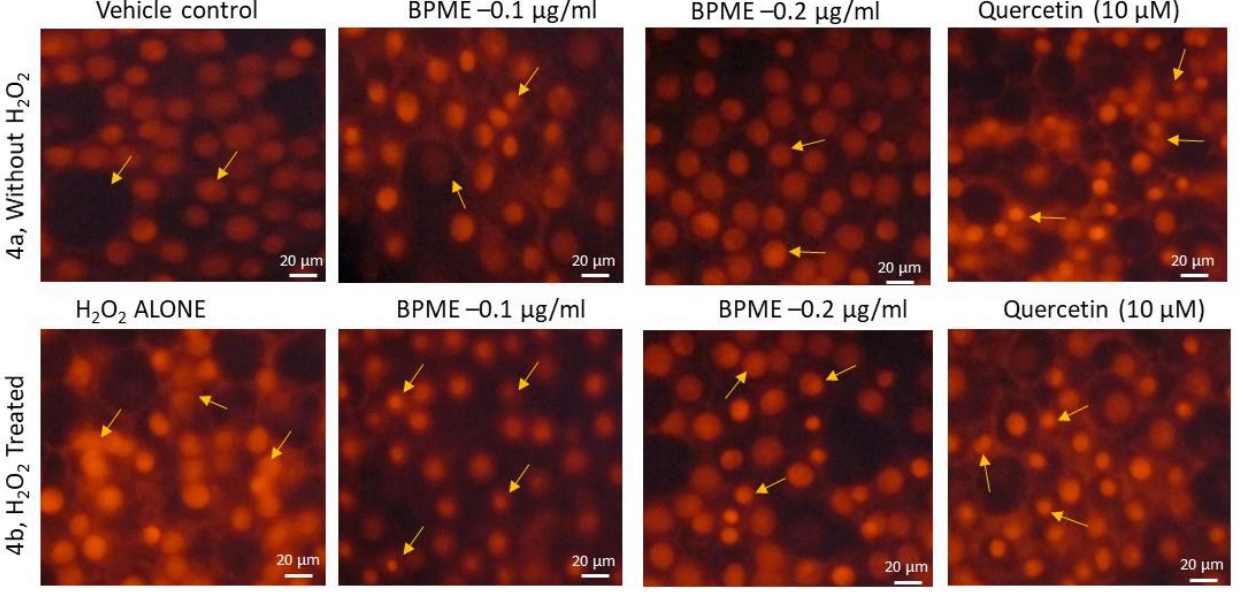
Figure 4. Propidium iodide (PI) staining analysis for nuclear morphology in vehicle control, 0.1 and 0.2 µ g/mL of beetroot peel methanol extract (BPME)-treated normal (3a) and H 2 O 2 -induced oxidative-stressed (3b) HUVECs after 48 h. In PI staining, vehicle control showing the nucleus appeared to be normal with no signs of shrunken, pyknosis or apoptotic nucleus. In H 2 O 2 alone, treated cells showed polarized nuclear membrane after 48 h. Treatment with 0.2 µ g/mL of BPME normalized the H 2 O 2 -induced nuclear membrane polarization when compared to 0.1 µ g/mL BPME or Quercetin 10 µ